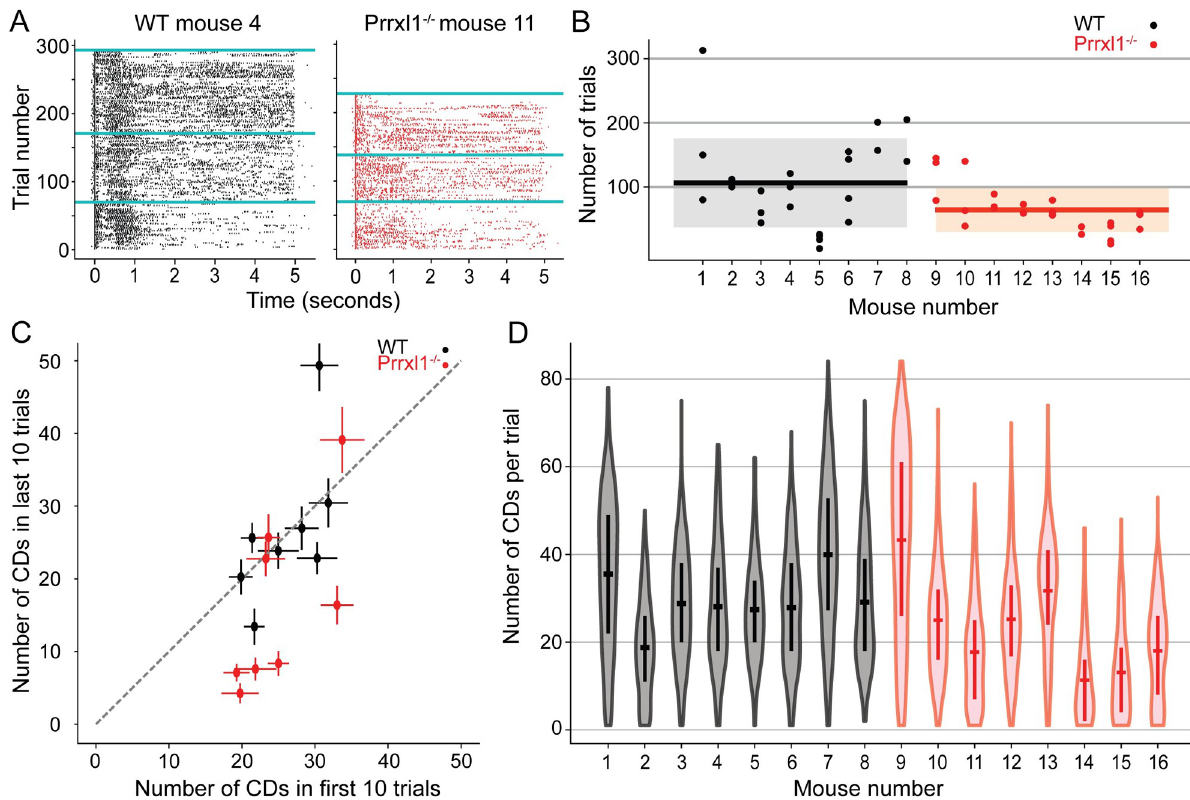
Fig 5. Knockout animals are less persistent and less consistent in their drinking behavior. Comparison of number of trials performed per experimental session, and number of CDs per trial for WT and KO mutant mice. (A) Typical CD raster plots WT (mouse 4, left) and KO (mouse 11, right). Each tick represents either a contact or a detach from the lick sensor. Both mice participated in three experimental sessions; sessions are divided by cyan horizontal lines. (B) WT (mice 1–8, black) tended to perform more trials than KO (mice 9–16, red). Means for both cohorts are shown as black horizontal lines, with standard deviations indicated by semi-transparent gray and red rectangles, respectively. (C) KO mice were less consistent in licking during a trial than the WT mice. Mouse numbers and colors as in (B). Licking activity for five of the eight KO mice falls well below the diagonal, while WT mice cluster close to the equality line. (D) This plot controls for the possibility that KO animals have a higher lick rate than WT and thus fatigue more quickly. KO and WT animals perform, on average, the same number of licks per trial (mean ± std: 23.2 ± 9.9 CD/trials for KO versus 29.4 ± 5.8 CDs/trial for WT; p > 0.17, two-sided t-test). Thus, the difference in the number of trials per session (B) and the decreased lick rate towards the end of the session (C) are not explained by a difference in effort spent per trial. Mouse numbers and colors as in